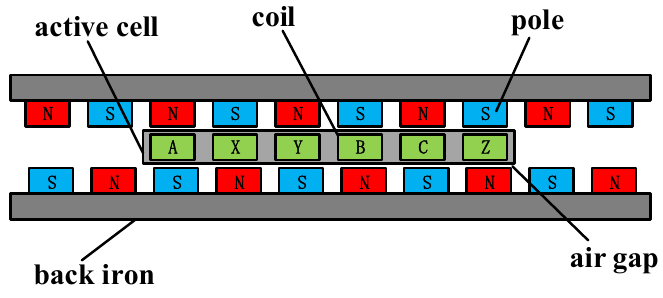
Figure 1. PMLSM model figure. PMLSM is a strong coupling and multivariable nonlinear system. In this paper, the mathematical model of a synchronous rotating coordinate axis is selected for controller analysis. It is assumed that in the motor air gap, the excitation magnetic field and armature reaction magnetic field have a sinusoidal distribution, ignoring the magnetic saturation effect, motor eddy current, and hysteresis loss, and ignoring nonlinear friction and other factors [18–20]. The voltage equation of PMLSM can be obtained as: